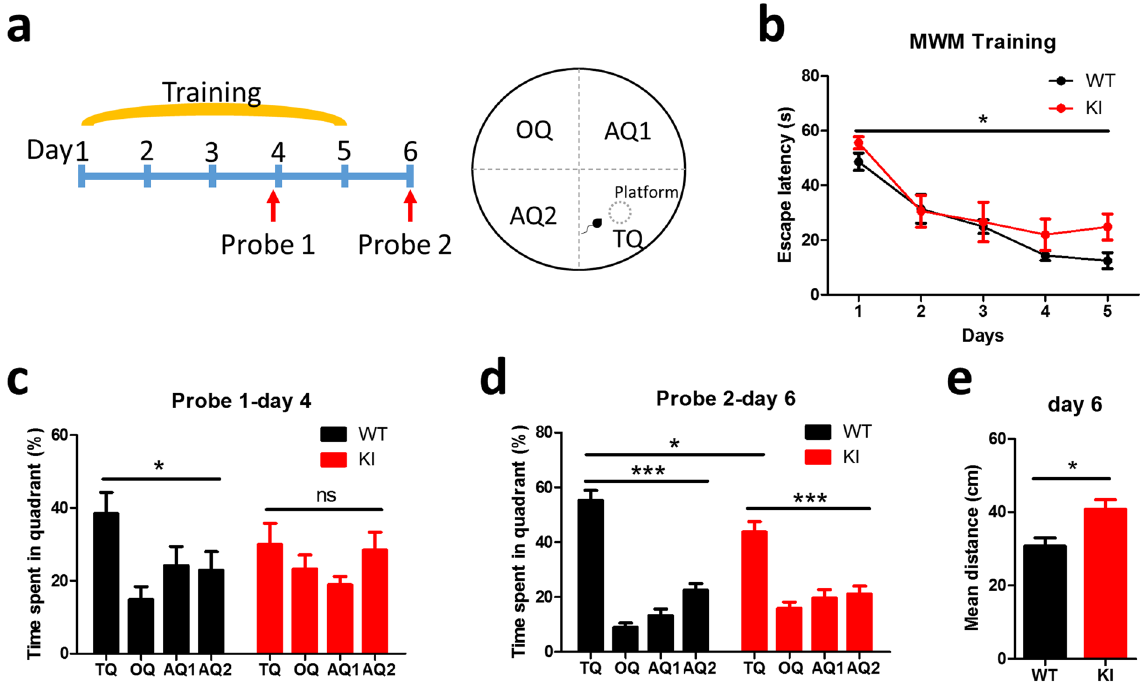
Figure 2. Lsd1 KI mice show impaired hippocampus-dependent spatial learning and memory. ( a ) Schematic drawings of experimental design and water maze. ( b ) Learning curve during 5 training days of Morris water maze (MWM) task showing the latency for the mice to reach the platform (WT: n = 8, KI: n = 7; two-way ANOVA, genotype x time, F 4,65 = 0.71, p = 0.590, effect of genotype, F 1,65 = 4.03, * p < 0.05, effect of time, F 4,65 = 20.16, p < 0.0001). ( c ) Time spent in each quadrant during 1-min probe test before training sessions on training day 4 (WT: n = 8, KI: n = 7; one-way ANOVA of WT, * p < 0.05, Bonferroni’s multiple comparison test, TQ vs OQ, p < 0.01; one-way ANOVA of KI, ns p = 0.307, Bonferroni’s multiple comparison test, TQ vs OQ, ns: not significant). ( d ) Time spent in each quadrant during 1-min probe test 24 h after day 5 training sessions (day 6) (WT: n = 8, KI: n = 7; one-way ANOVA of WT, *** p < 0.0001; one-way ANOVA of KI, *** p < 0.0001; unpaired t -test, WT vs KI in TQ, * p < 0.05). TQ: target, OQ: opposite, AQ1: right, AQ2: left quadrant. ( e )